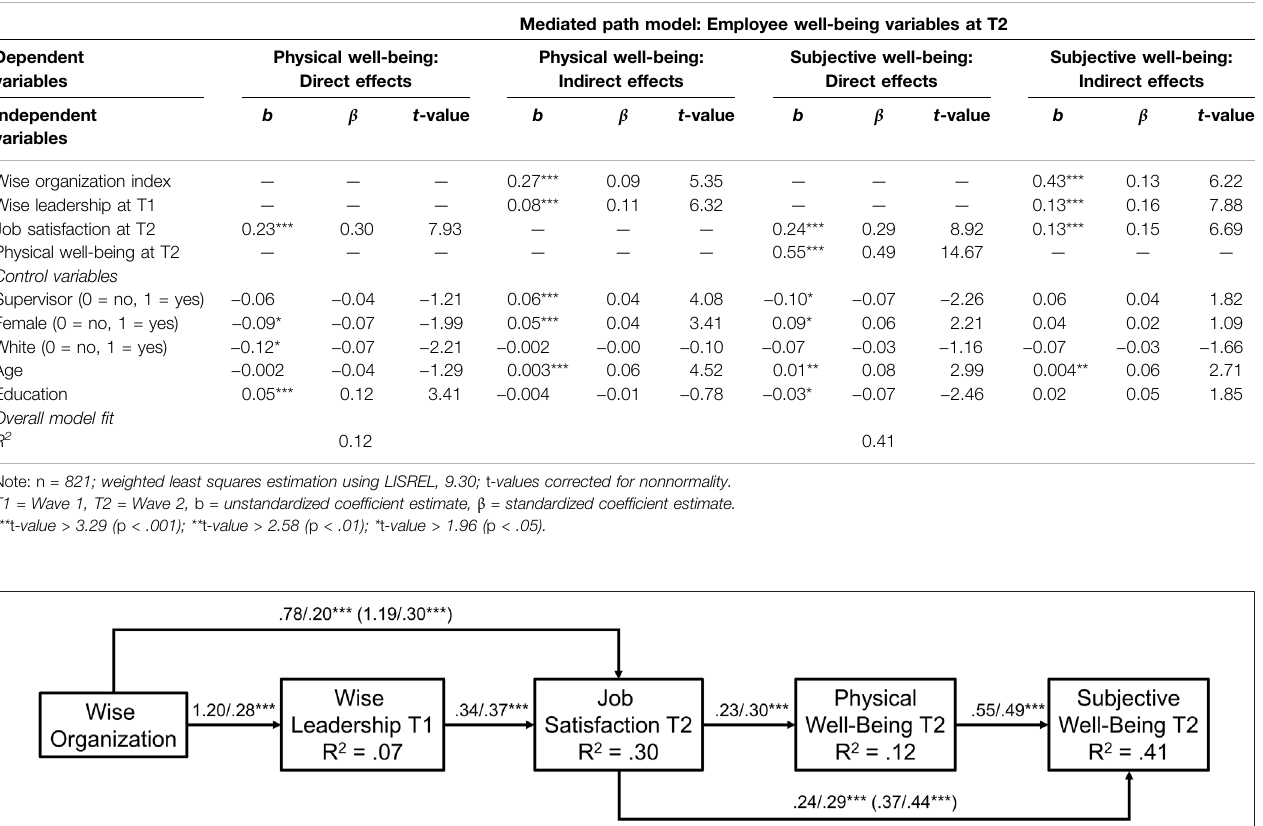
Frontiers in Communication |